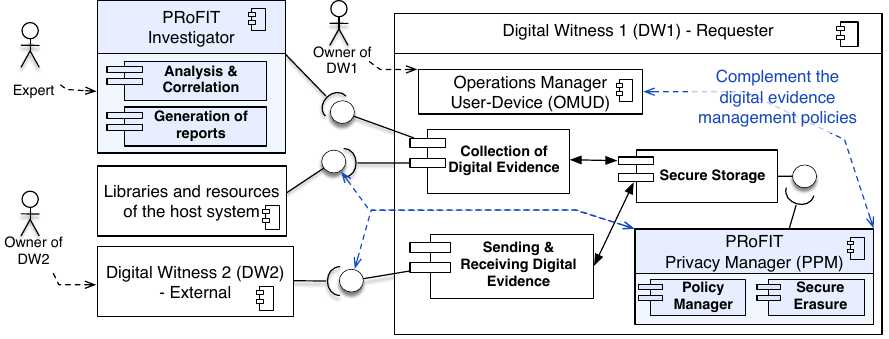
Figure 5. PRoFIT-compliant Digital Witness